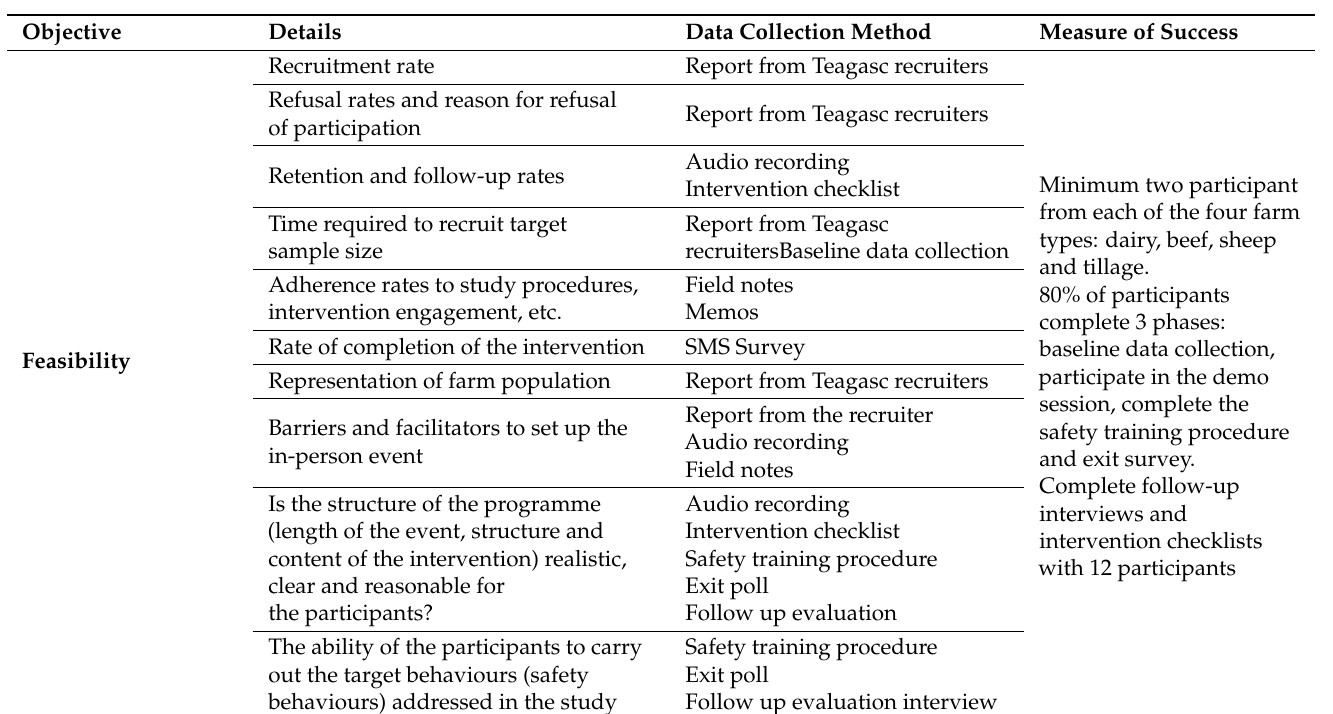
Table A4. Evaluation